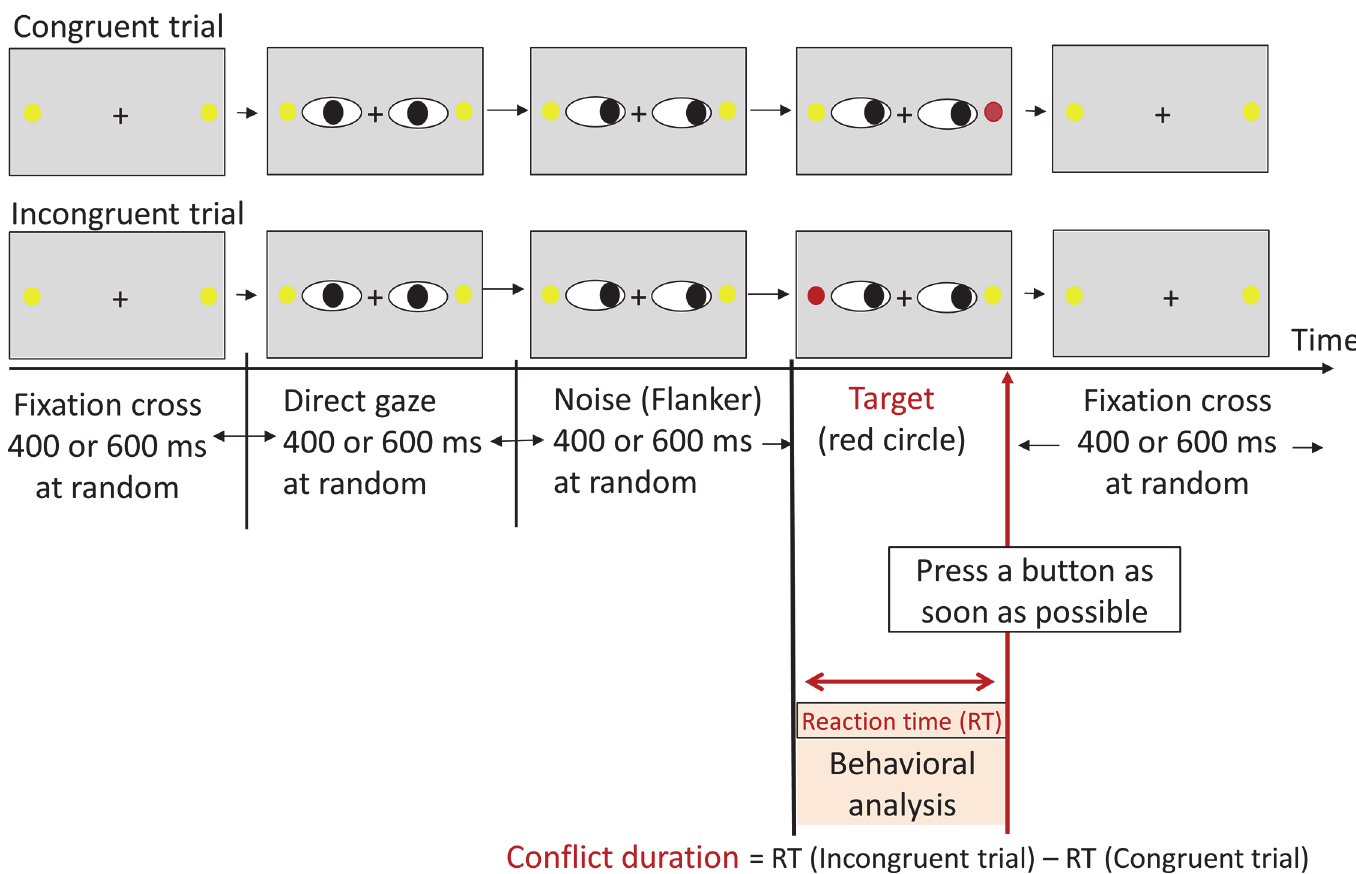
Fig 2. Flanker task paradigm. Each trial involved both eyes and two dots. The trial began with a fixation cross. After a random duration of 400 or 600 ms, lateral eye movements were presented as flanker distractors. Then, a color alteration of the dot followed after a random duration of 400 or 600 ms. The target stimulus was a red dot, which vanished immediately after the participant ’ s response (i.e., button pressing). Finally, a fixation cross was presented again for 400 or 600 ms before the next trial. A total of 148 trials (74 congruent trials and 74 incongruent trials) were presented in a randomized order. The total time of the task was approximately 7